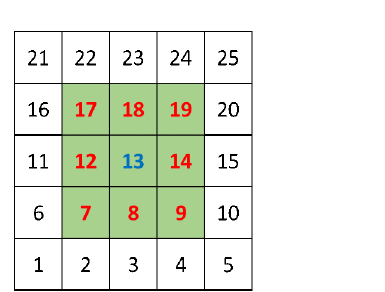
Figure 4. Grid cells.